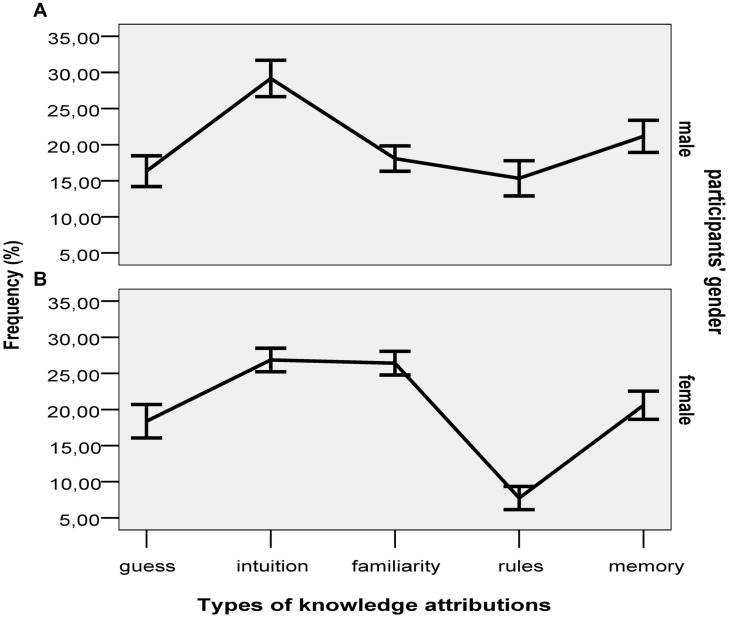
Percentage of knowledge attributions in males (A) and females (B). Error bars indicate ±1 SE.